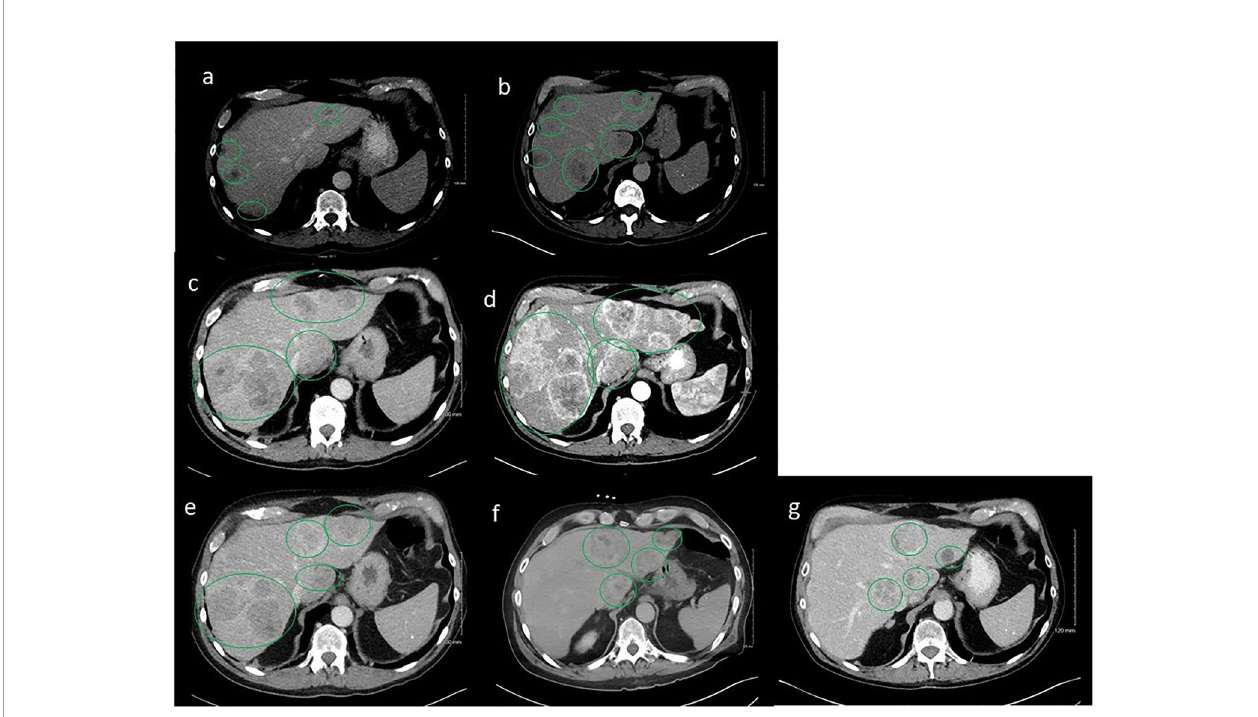
FIGURE 3 | Serial computerized tomography (CT) images of abdomen and pelvis with contrast of the patient ’ s tumor after sequencing treatments. Green oval cycles represent tumors. (A) Prior to docetaxel, March 2020. (B) Six cycles after docetaxel, June 2020. (C) Two months after enzalutamide, August 2020. (D) After three cycles of cabazitaxel, October 2020. (E) After Y-90 embolization to the right lobe of liver concurrent with carboplatin/abiraterone acetate, December 2020. (F) After Y-90 embolization to the left lobe of liver concurrent with carboplatin/abiraterone acetate, January 2021. (G) On carboplatin/abiraterone acetate, May